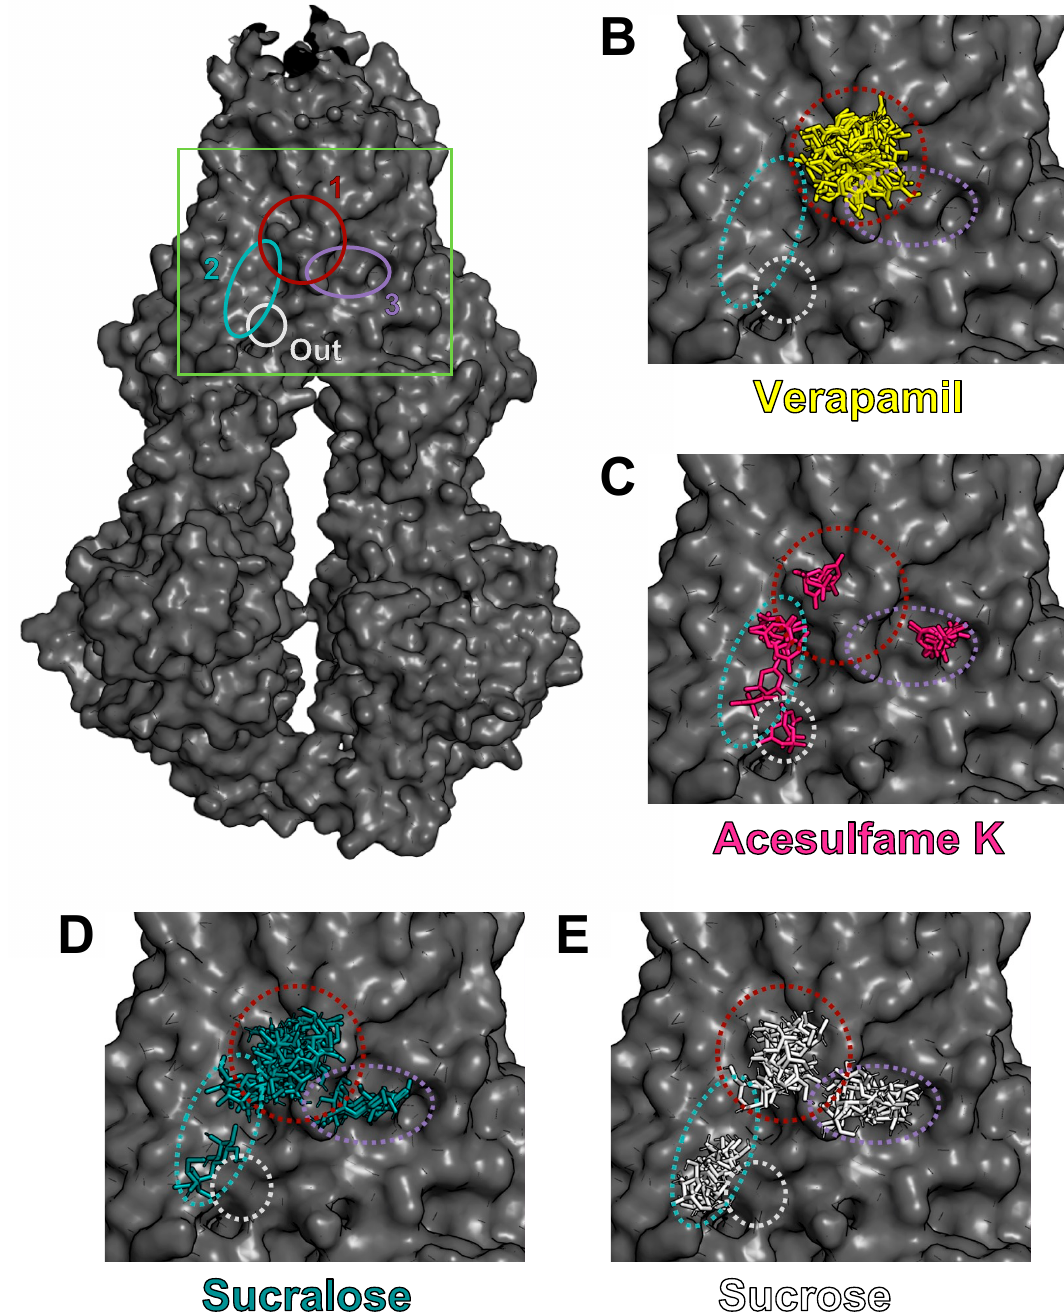
Figure 4. Molecular docking experiments show AceK and Sucr in PGP binding pockets. Docking experiments were performed with AutoDock Vina and figures were prepared with PyMOL. Structure for full-length PGP retrieved from RCSB Protein Data Bank (PDB: 7A65). 3D structures for Verapamil, AceK, and Sucr retrieved from ZINC. ( A ) Structure of human PGP from cryo-EM (PDB: 7A65) showing the location of main binding pockets in transmembrane region. ( B – E ) Insert of transmembrane region showing PGP with Verapamil ( B ), AceK ( C ), Sucr ( D ), or Sucrose ( E ) docked in binding pockets. Binding pockets are shown as: Pocket 1:burgundy; Pocket 2:indigo; Pocket 3:teal; External binding site:gray.